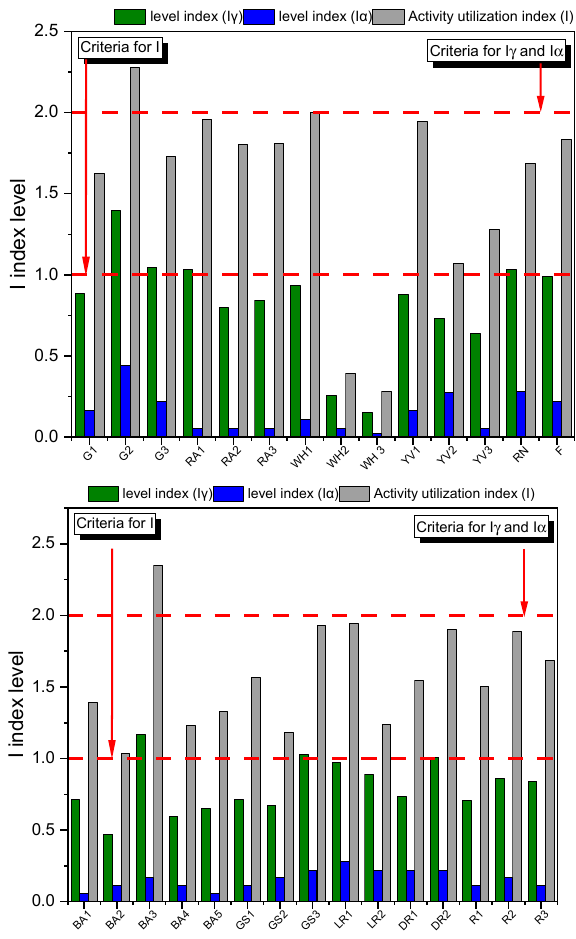
Figure 9. External ( γ -radioactivity) and internal ( α -radioactivity) level indices and activity utiliza- tion